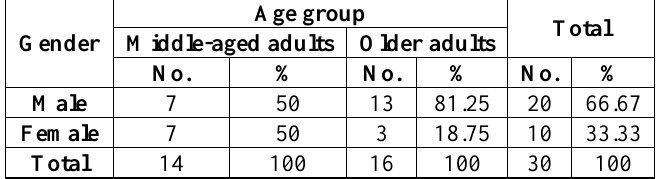
Table 1: Distribution of the total sample by age group and gender Gender